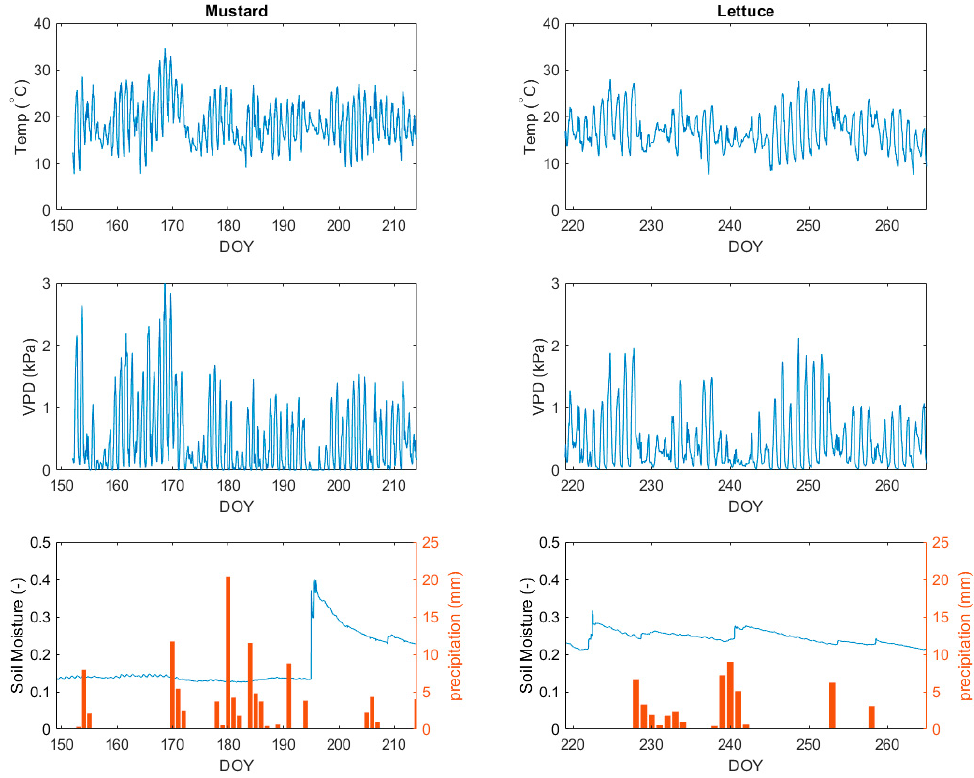
Figure 3. Description of the meteorological conditions during the growing season for mustard and